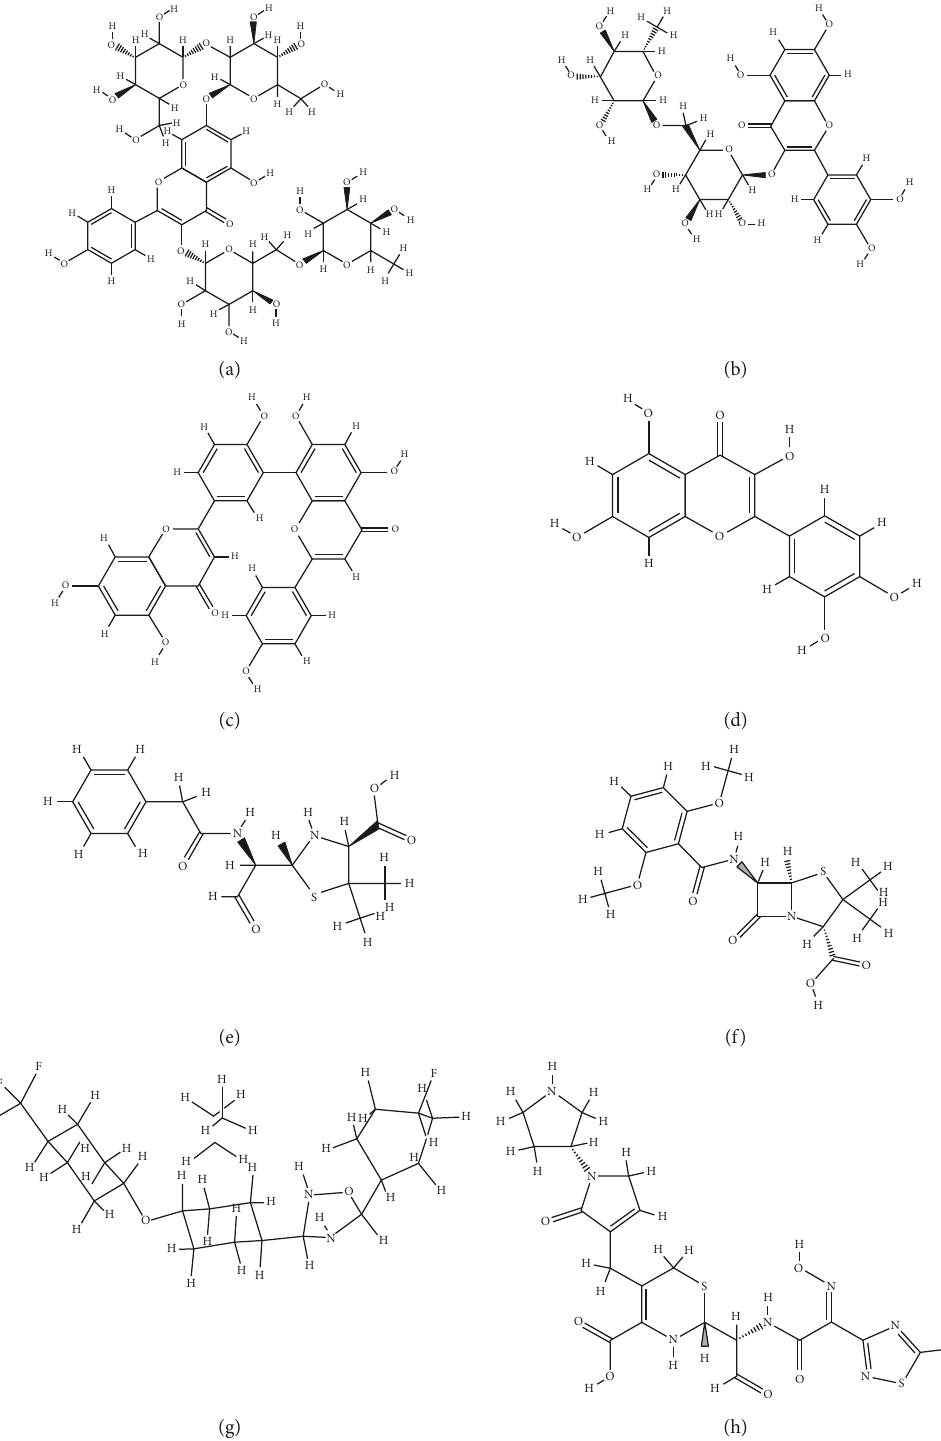
Figure 1: Two-dimensional structures of (a) kaempferol 3-rutinoside-7-sophoroside, (b) rutin, (c) amentoflavone, (d) quercetin, (e) penicillin G, (f) methicillin, (g) oxadiazole, and (h)